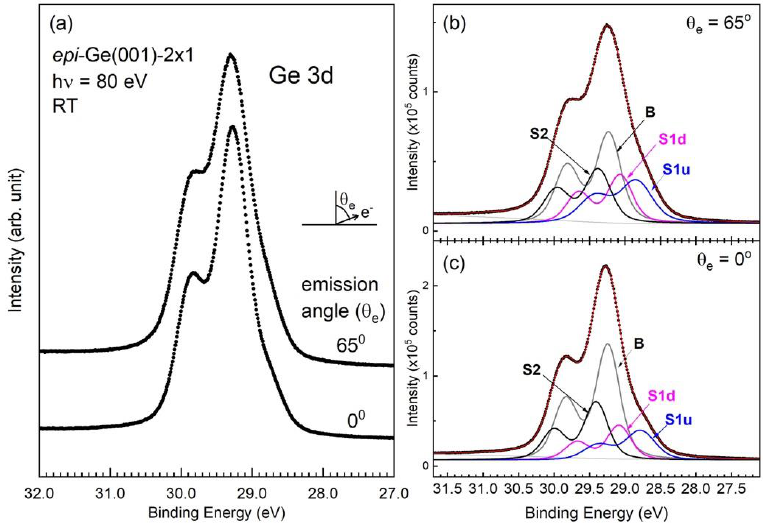
Figure 2. ( a ) Photoemission data from as-grown epi Ge(001)-2 × 1 taken in normal ( θ e = 0°) and off-normal ( θ e = 65°) emission at photon energies (h ν ) = 80 eV at room temperature. ( b ) A simultaneous fit to the 65°-emission spectrum. ( c ) A simultaneous fit to the normal-emission spectrum.